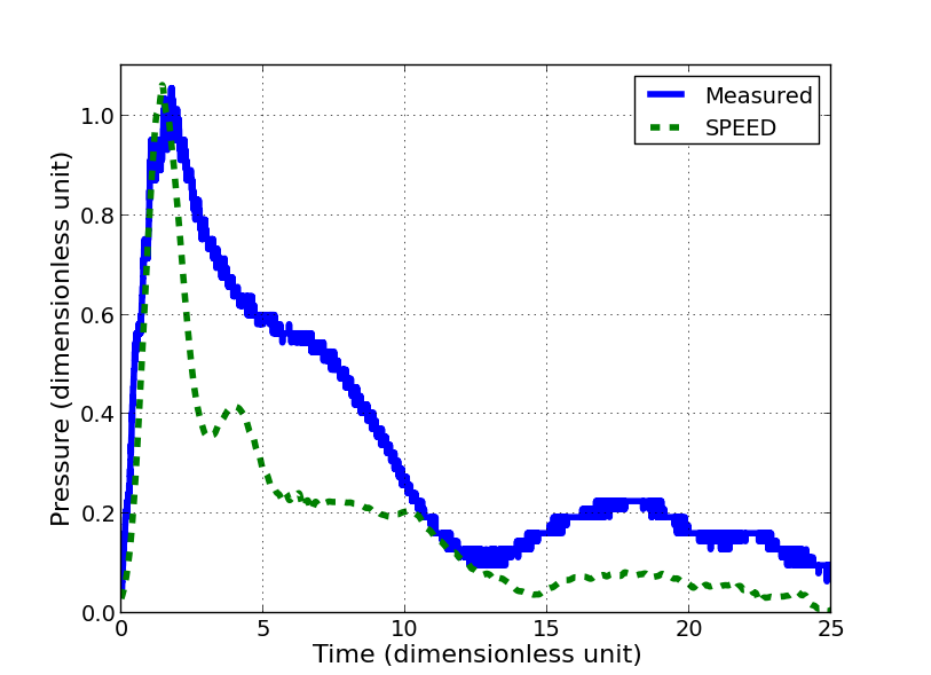
Figure 15. Dimensionless measured pressure with pressure sensor on steel anvil with an explosive at 40 charge radii and SPEED ® recored signal in PVDF with equivalent simulation, with 0.1 mm element